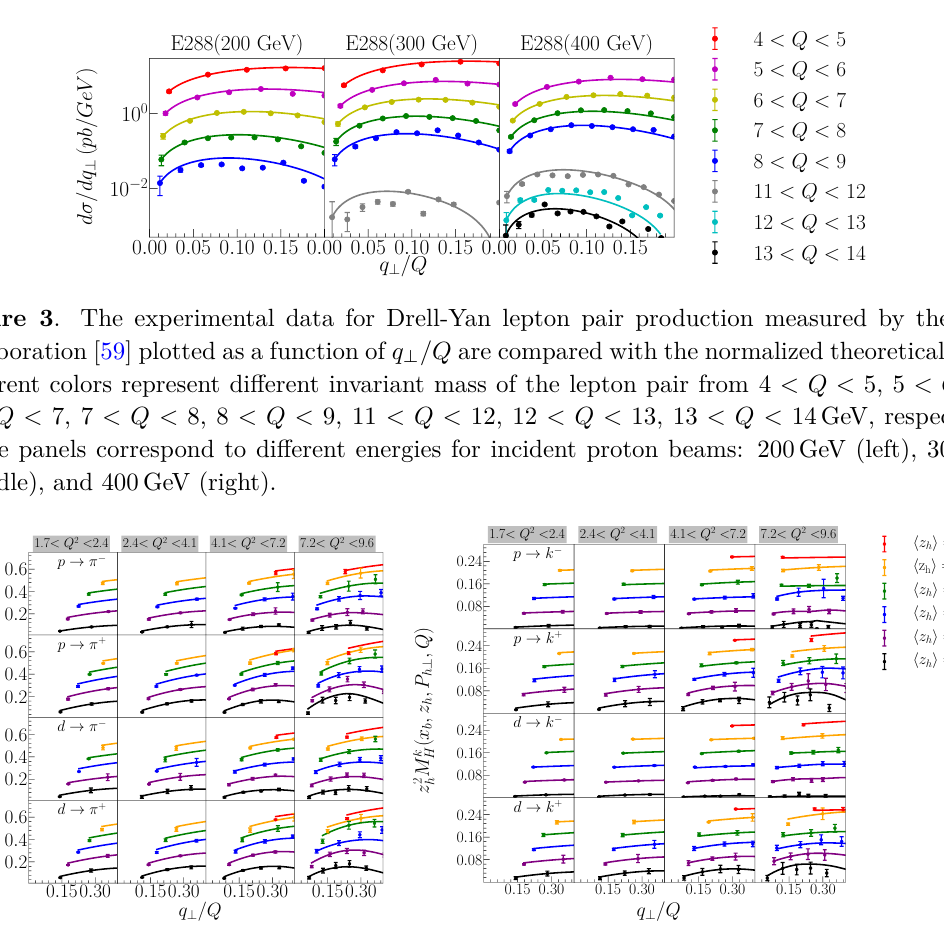
Figure 4 . Left panel: the HERMES multiplicity data in [60] for pion production from either a proton (denoted as p → π ) or deuteron (denoted as d → π ) target. For better presentation, the data is offset by 0.0 for h z h i = 0 . 53 , 0.1 for h z h i = 0 . 42 , 0.2 for h z h i = 0 . 34 , 0.3 for h z h i = 0 . 28 , 0.4 for h z h i = 0 . 23 , and 0.5 for h z h i = 0 . 15 . Right panel: the HERMES multiplicity data for kaon production. The offsets are half of the offsets from the